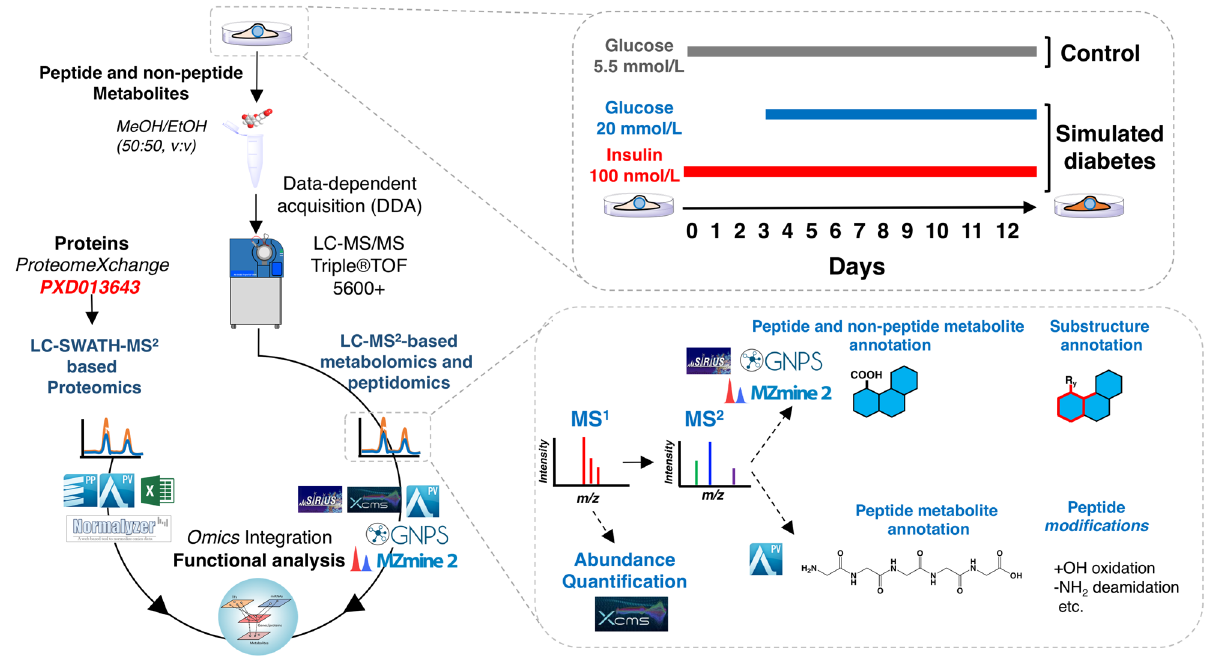
Figure 1. Illustration of the methodology followed in this